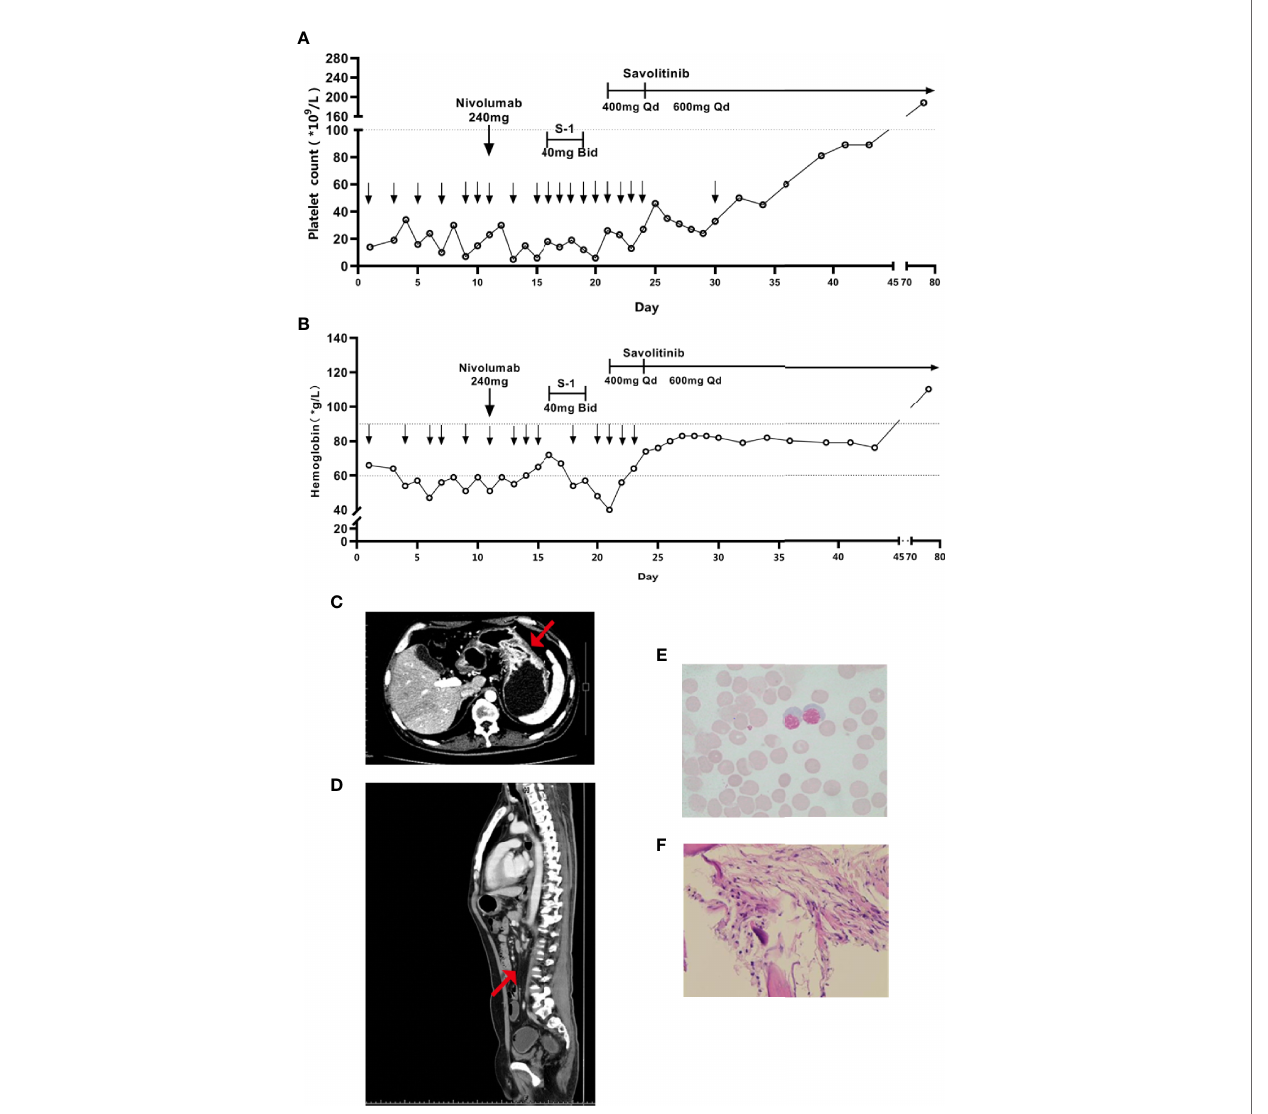
FIGURE 3 | Variation trends of (A) platelet and (B) hemoglobin since admission, the lower downward arrow represents the date of platelet and hemoglobin transfusion, respectively. After savolitinib treatment, enhanced CT showed that (C) the thickness of gastric wall was thinner and (D) the abdominal lymph nodes were shrunk and fewer, the red arrow represents the location of the lesion; and post-treatment Hematoxylin-eosin staining of (E) the bone marrow smear and (F) the bone marrow